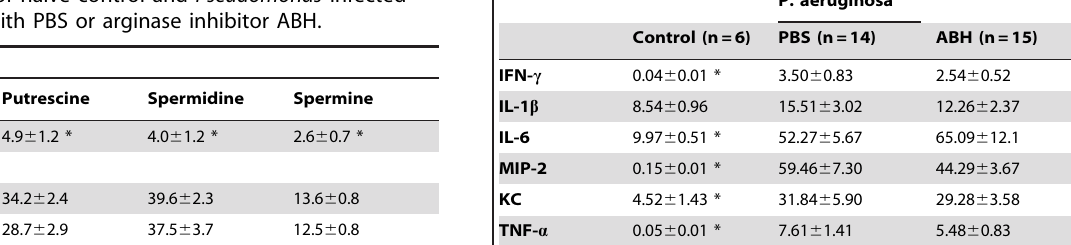
Concentrations were significantly different between groups (p , 0.001, Kruskal- Wallis test). All cytokines with the exception of IL-1 b were lower in controls compared to infected animals not different between PBS and ABH treated